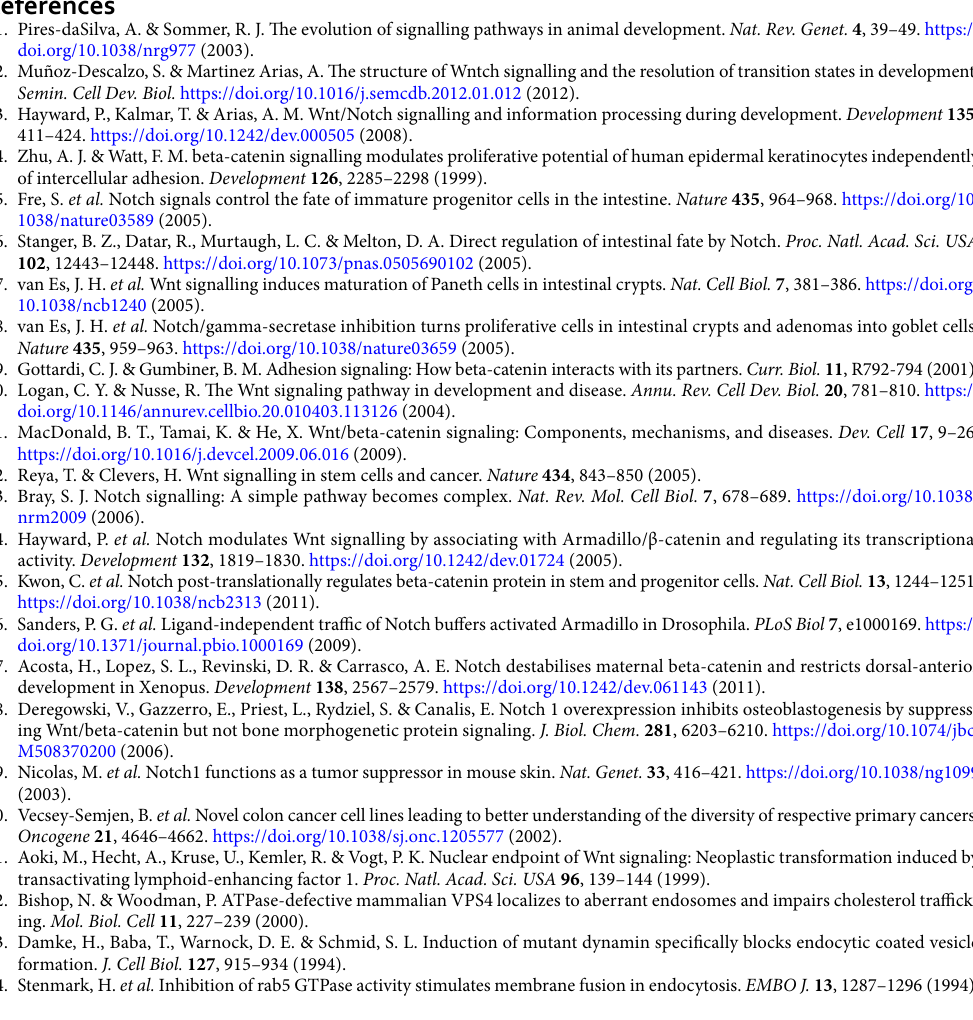
Figure 5. Notch inhibits β-catenin-driven transcription through an interaction between the two proteins. ( A ) NICD and ΔEGF_N1 did not alter the cytosolic levels of endogenous β-catenin or S45Fβ-catenin. Western blot analysis of cytosolic fractions of HEK293T cells expressing S45Fβ-catenin alone or with NICD or ΔEGF_N1. Note expressing S45Fβ-catenin induced the cytosolic accumulation of endogenous β-catenin. Proteins were detected with antibodies that recognise endogenous β-catenin and the myc-epitope found in the NICD and ΔEGF_N1. Glycogen synthase kinase 3 beta is shown as loading control. The position of molecular weight markers is shown in KDa. ( B ) NICD and ΔEGF_N1 did not affect the complex formation between TCFV1 and V2β-catenin. Venus fluorescence was used to monitor complex formation. RFP fluorescence was used to detect NICD, ΔEGF_N1, DNHes5 and RFP protein expression. Quantification of the number of nuclei expressing NICD, ΔEGF_N1, DNHes5 or RFP where complex formation between TCFV1 and V2β-catenin was also observed. Scale bar is 50 μm. Experiments were performed in triplicate. Data are presented as percentage co-localisation(± SEM) of NICD, ΔEGF_N1, DNHes5 or RFP with Venus fluorescence (* P < 0.05 compared to co-localisation seen with RFP one-way ANOVA and Tukey’s post-hoc test, N = 3). ( C ) Detection of a protein complex between β-catenin and NICD. GFP-tagged NICD and RBPj were isolated by immunoprecipitation from total nuclear lysates using an antibody that recognises GFP. The presence of β-catenin within these complexes was analysed by western blotting for β-catenin with an antibody that recognises the V5 epitope within the β-catenin protein. The position of molecular weight markers is shown in KDa. Original uncropped Western Blot images of panel A and C are shown in Supplementary Fig.